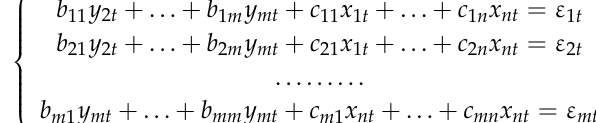
parameters, c ij are the x ij exogenous variable’s parameters, i=1, …, m , j=1, …, n , and ε comprises the error term (residuals) [61].